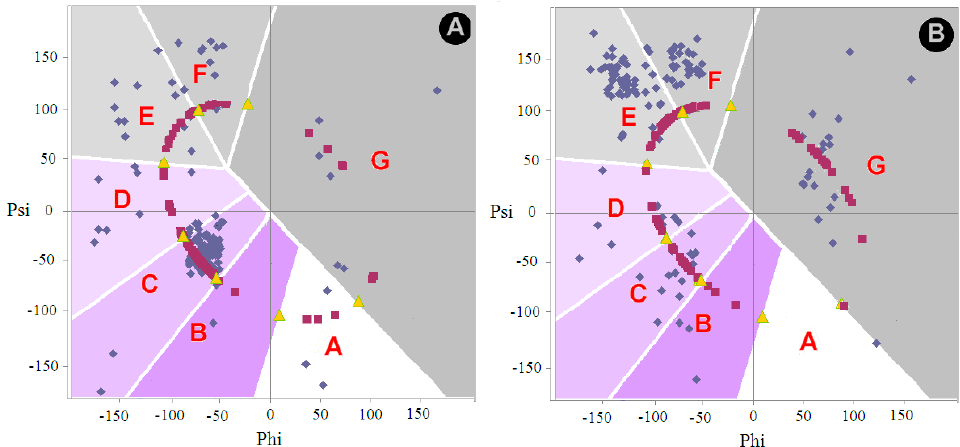
Figure 1. The distribution of angles Phi and Psi on the background for A—micelle-bound ASyn (1XQ8), B—amyloid form (2N0A). The image is limited to the fragment 30–100. Blue points—Phi, Psi angles for structures available in PDB, red points—Phi e , Psi e , yellow points—zone boundaries for structural codes. Phi e and Psi e —position of Phi and Psi angles after transformation to the ellipse (subscript “e”) (shortest distance criterion). This operation is assumed as a step-back of the final structure of protein under consideration to its early structural form. A–G – zones on Ramachandran map distinguished according to local maxima on the ellipse path.